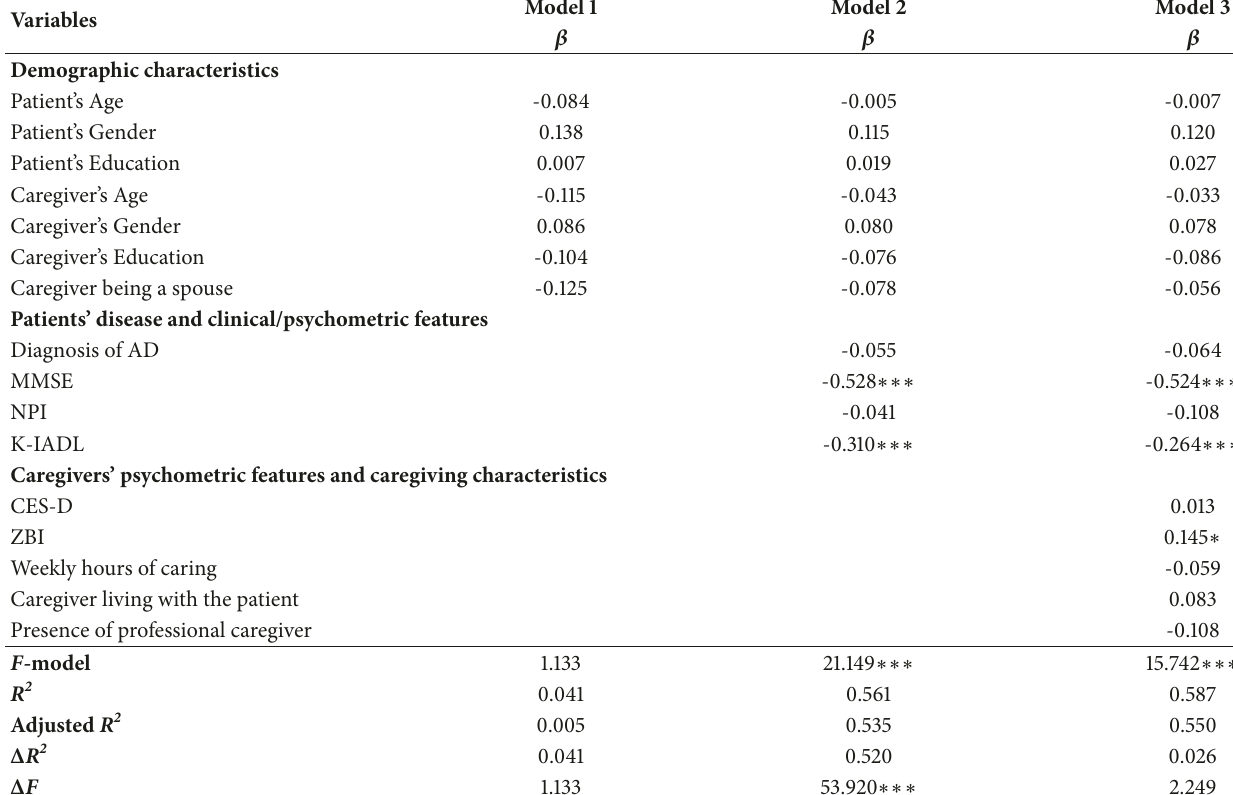
Table 2: Summary of hierarchical regression analysis to identify the contribution of patients’ and caregivers’ characteristics on GDS scoring.